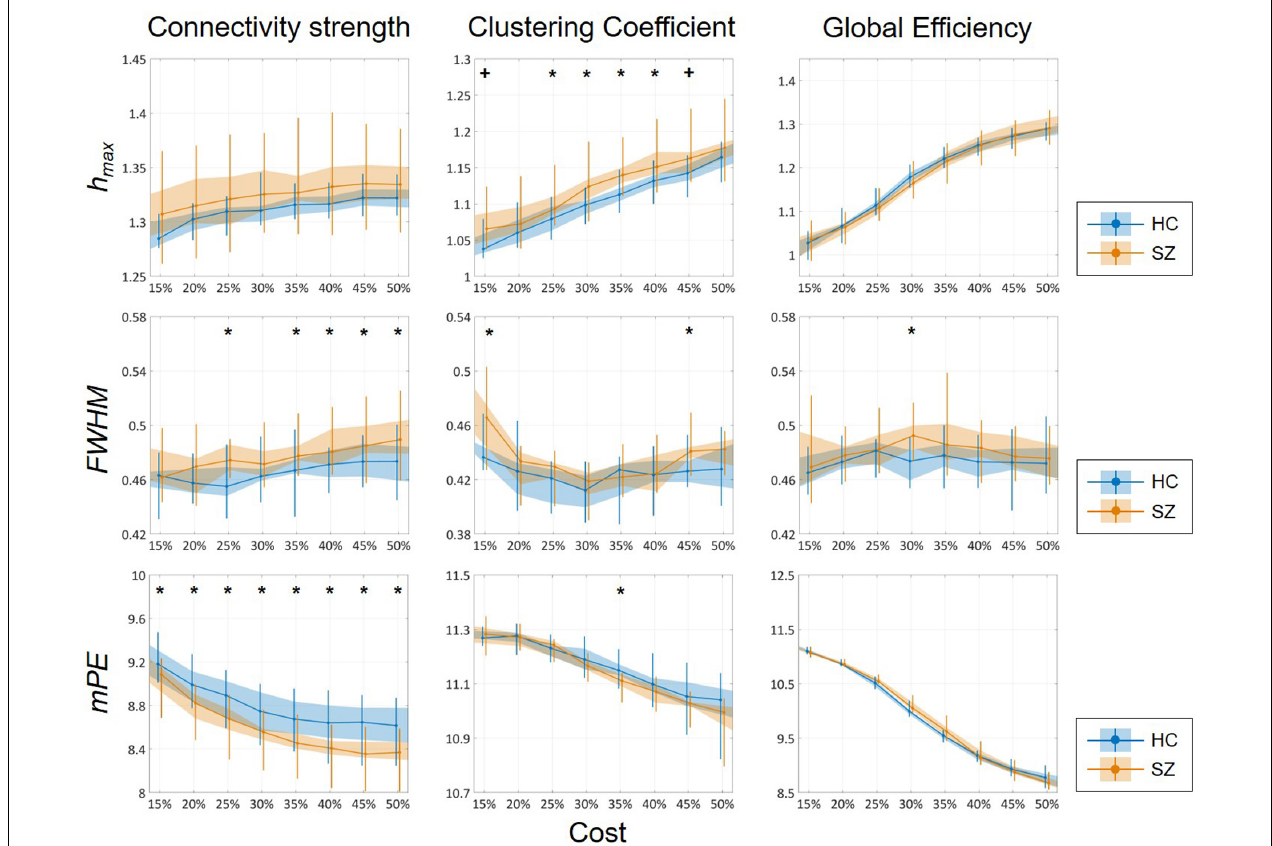
FIGURE 6 | Cost-dependent results of multifractal and entropy analysis of network measures. Multifractal measures ( h max and FWHM ) and modified permutation entropy ( mPE ) of all three network measures are plotted as functions of the cost. Black markers indicate significant group level difference ( p < 0.05, corrected). * Two-sample t -test; + Mann–Whitney U -test; HC, healthy control; SZ, schizophrenia.